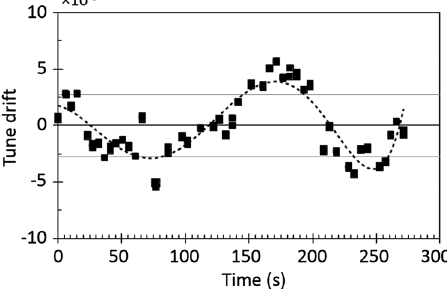
FIG. 14. A slow tune jitter with a ∼ 100 s period is observed during the tune measurements. Thin grey lines represent the resulting rms tune deviation of about 2 × 10 − 4 .